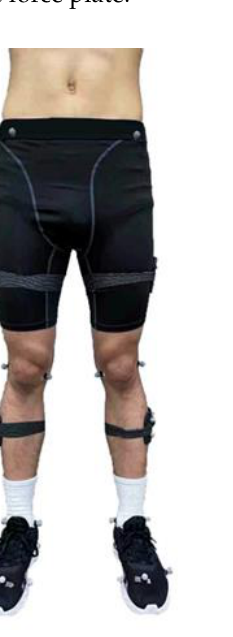
Figure 2. Illustration of retroreflective markers placement.